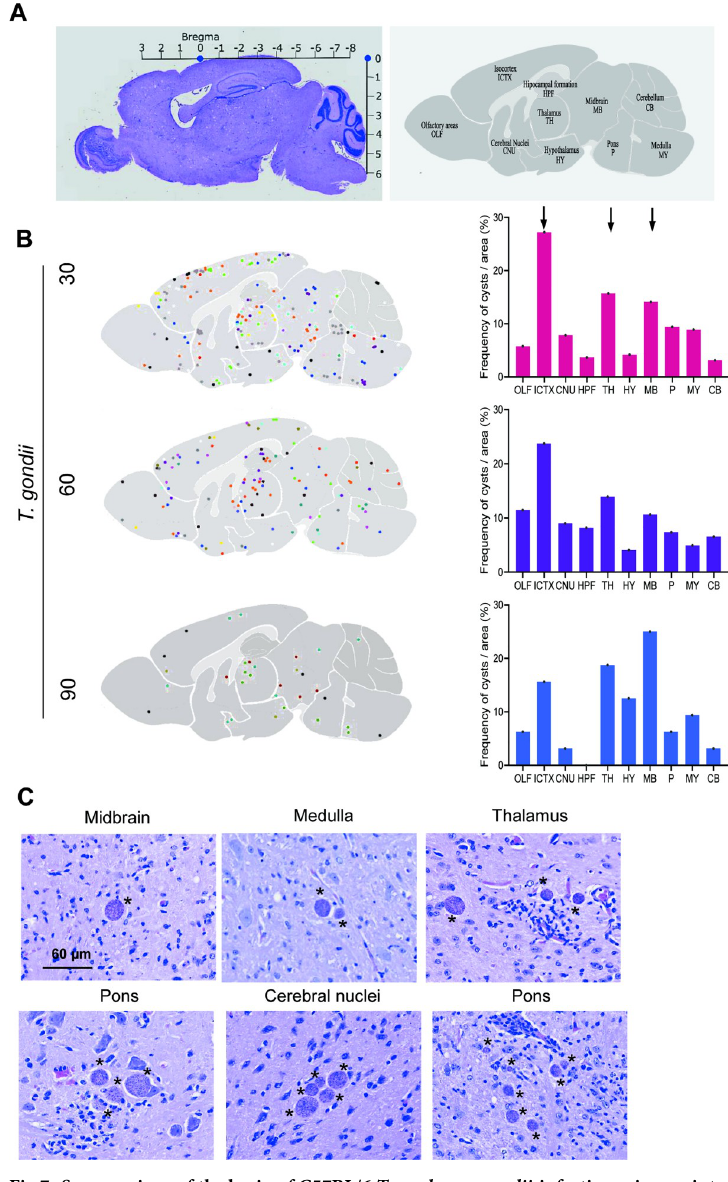
Fig 7. Some regions of the brain of C57BL/6 Toxoplasma gondii -infection mice are intensely infected. ( A ) The stereotaxic coordinates of the bregma of the mouse´s brain were used to construct representative maps of the topographic location of the cysts in each brain area: Olfactory areas (OLF), Isocortex (ICTX), Cerebral Nuclei (CNU), Hippocampal formation (HPF), Thalamus (TH), Hypothalamus (HY), Midbrain (MB), Pons (P), Medulla (MY) and Cerebellum (CB). ( B ) The cysts were localized in all brain regions, but the isocortex, thalamus and midbrain were colonized more intensely in the early (30 dpi) and long-term (60 and 90 dpi) chronic infection (each color represents an individual mice). The histograms show the percentage of cysts per area studied. ( C ) Representative pictures show individual cysts or multiple cysts per microscopic field in different brain areas, associated or not with inflammatory foci. Bar = 60 μ m. Each experimental group consisted of 4–10 T . gondii -infected mice. Data were analyzed using ordinary one-way ANOVA. pattern was preserved in the three analyzed timepoints (Fig 7B and S3A Fig), supporting the existence of differential accumulation of T . gondii cysts in these CNS tissue areas. The size of the cysts does not vary due to the region in which they are located S3B Fig. Further, most cysts